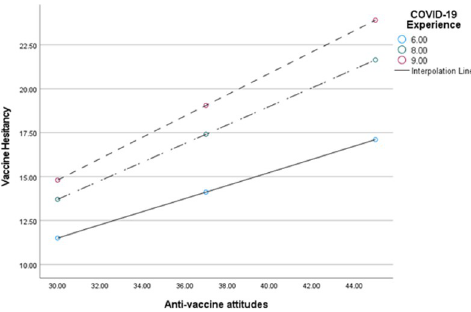
Fig 1. Interaction effect between vaccine hesitancy and anti-vaccine attitudes as moderated by experience with COVID-19. NB: COVID-19 Experience = Moderator. ‘6.00’ = Low COVID-19 Experience; ‘8.00’ = Mid Covid-19 Experience; ‘9.00’ = High Covid-19